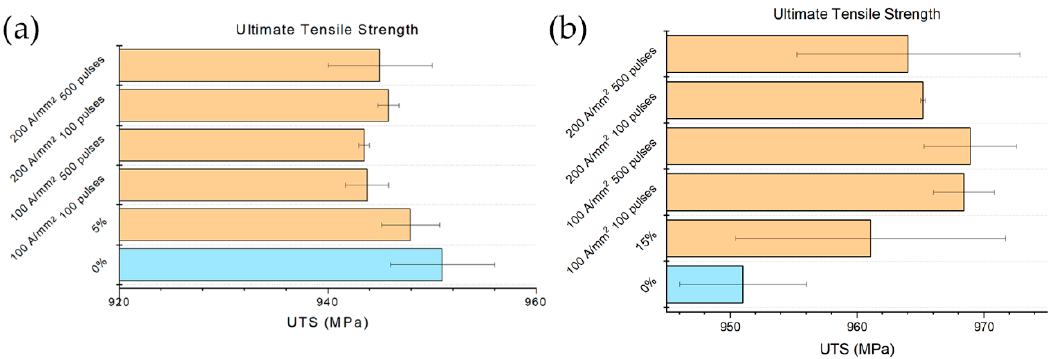
Figure 12. Evolution of UTS with respect the different electropulsing treatments and references ( a ) 5% prestrained specimens and ( b ) 15% prestrained specimens.